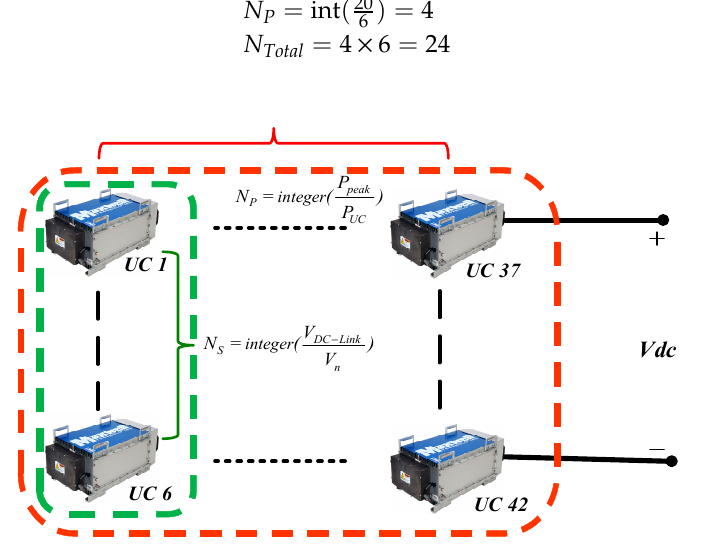
Figure 11. UC bank sizing based on the required power.